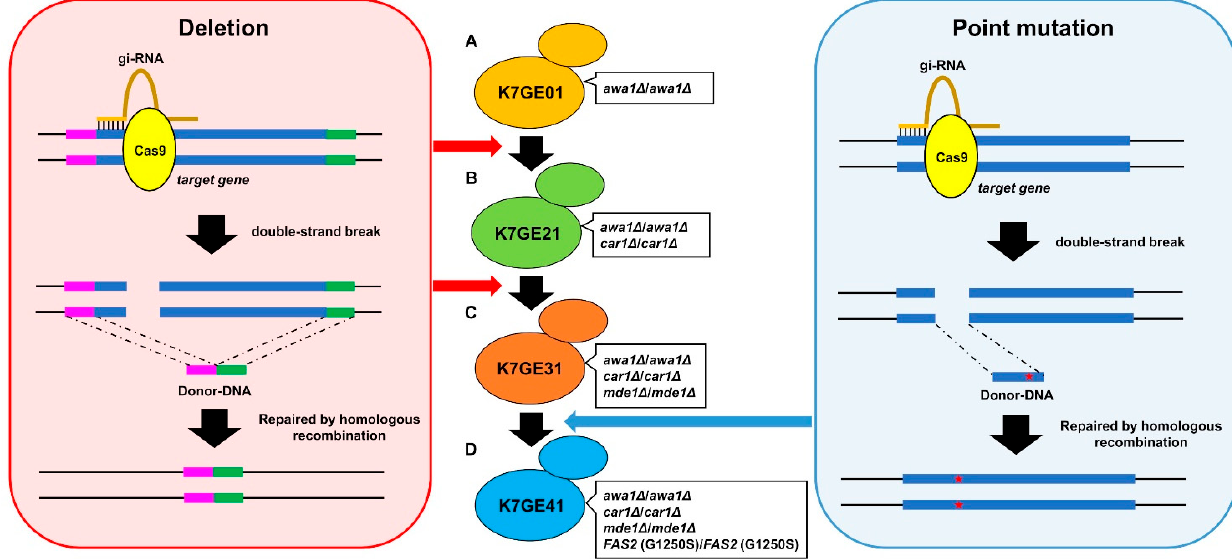
Figure 1. Serial breeding of a sake yeast strain with eight mutations. A double-strand break was introduced in the target gene by CRISPR-Cas9. Homologous recombination repair was performed using donor DNA (150 bp) to introduce gene deletion (light red region) or point mutation (light blue region). Starting from K7GE01 (yellow) with AWA1 deletion ( A ), K7GE21 (green) with CAR1 deletion ( B ), K7GE31 (orange) with MDE1 deletion ( C ), and K7GE41 (blue) with FAS2 (G1250S) point mutation ( D ) were generated successively. The final K7GE41 sake yeast strain harbored homozygous eight mutations that confer excellent brewing characteristics.